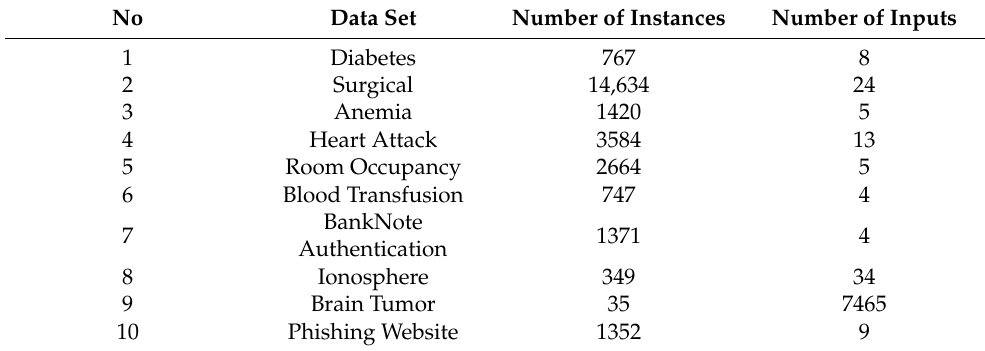
Table 2. Properties of used data